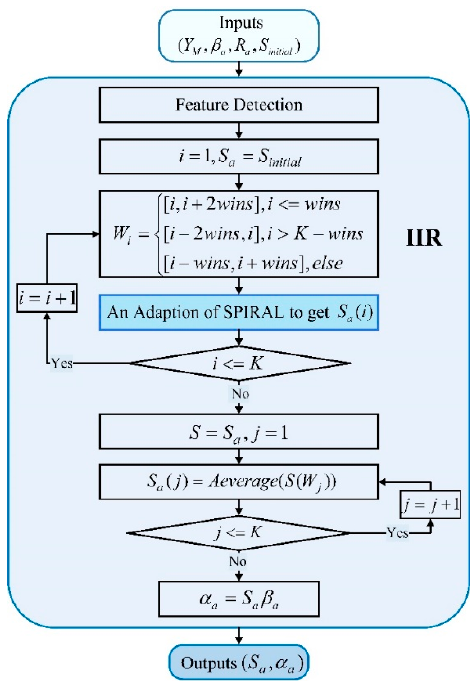
Figure 2. Flow diagram for the aerosol extinction coefficient and the lidar ratio retrieval in the iterative image reconstruction (IIR) method. The details of the adaption of sparse Poisson image reconstruction algorithm (SPIRAL) are described in Section 2.4.